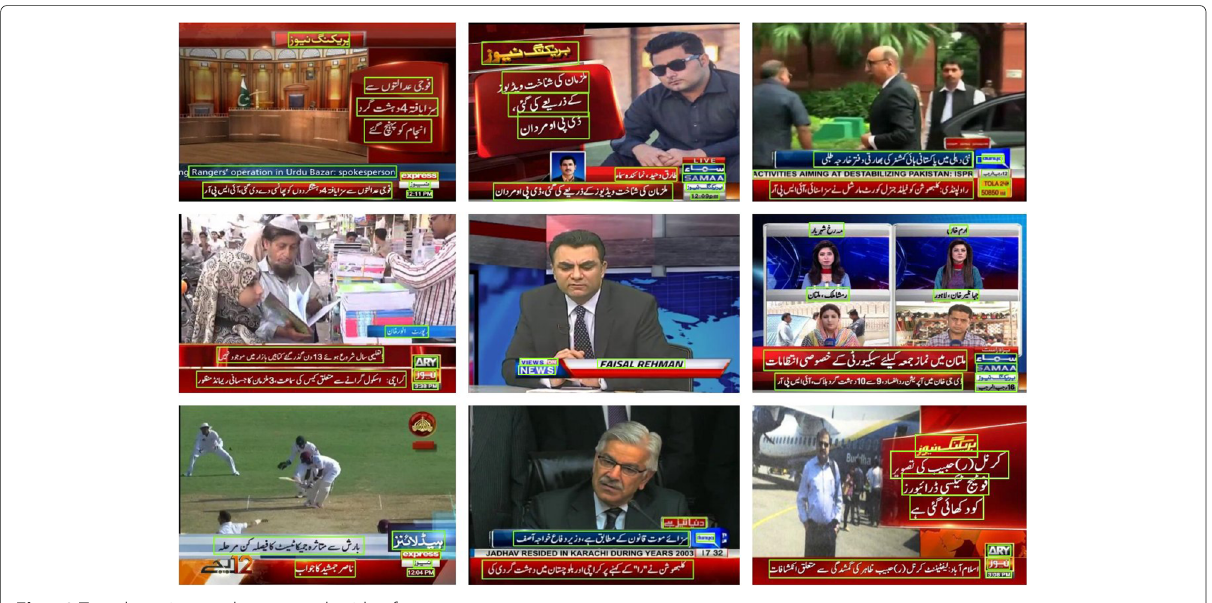
Fig. 12 Text detection results on sample video frames